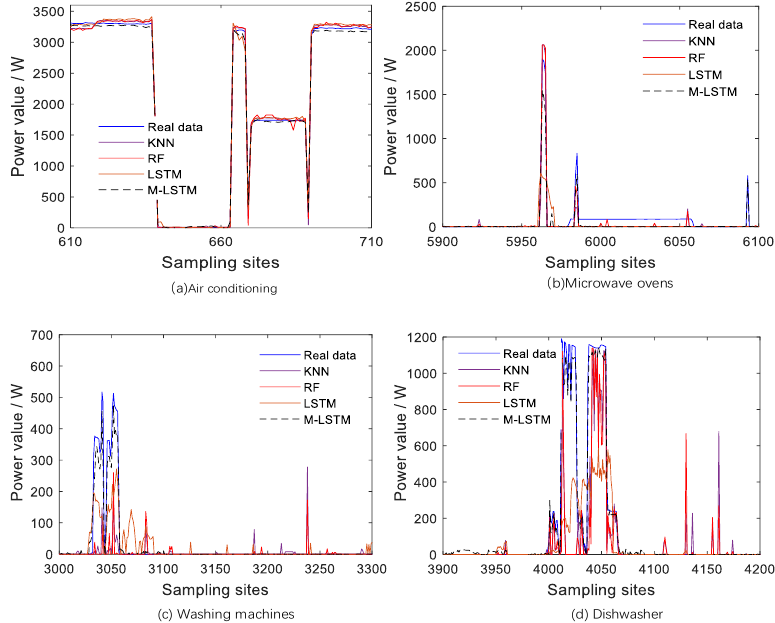
Figure 8. Comparison of local load decomposition for WikiEnergy 25 home.